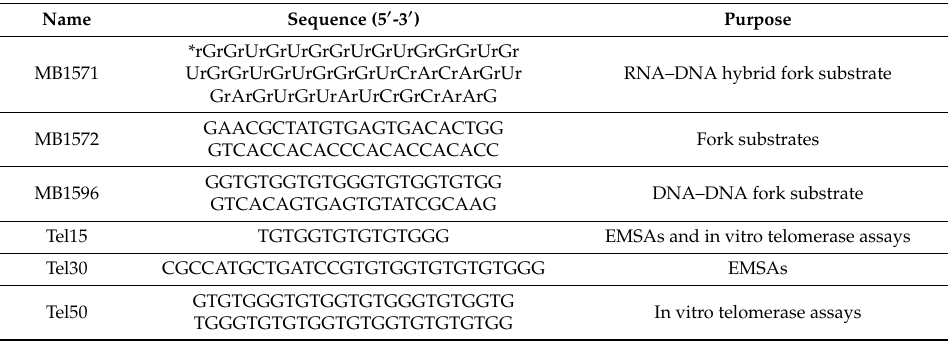
Table 2. Oligonucleotides used in this